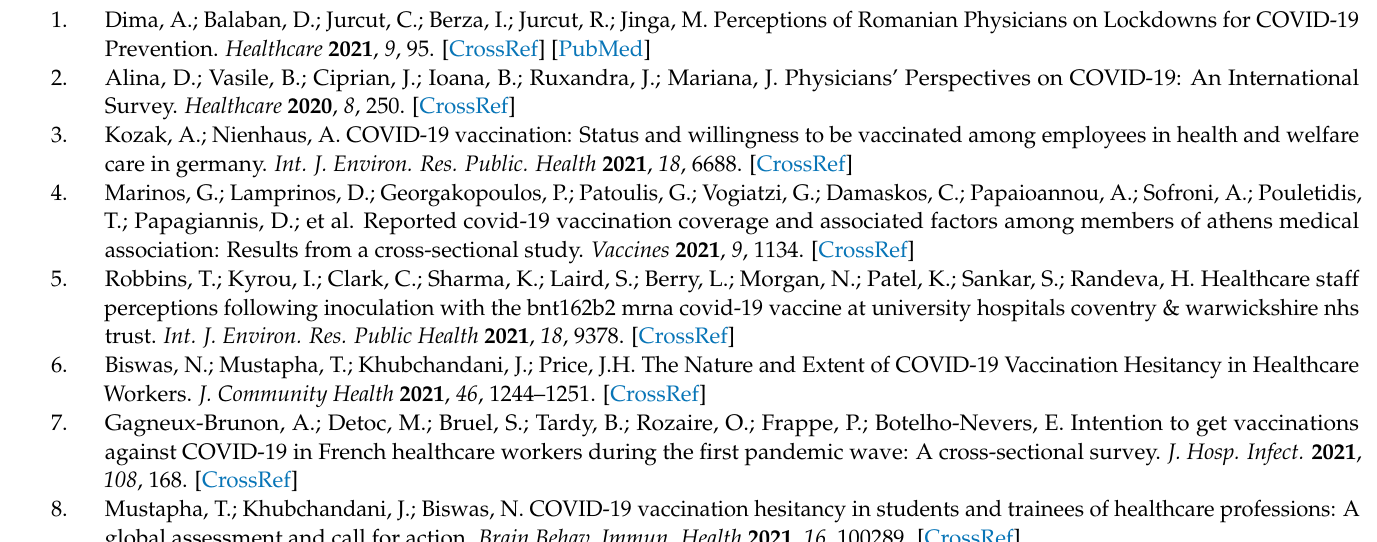
Supplementary Table S1. General characteristics of the physicians ‘respondents in the study; Supple- mentary Table S2. Side effects related to the first COVID-19 vaccine dose; Supplementary Table S3. Diagnostic of the COVID-19 disease in the physicians’ respondents to the survey and Supplementary Table S4. COVID-19’s characteristics in the physicians’ respondents to the